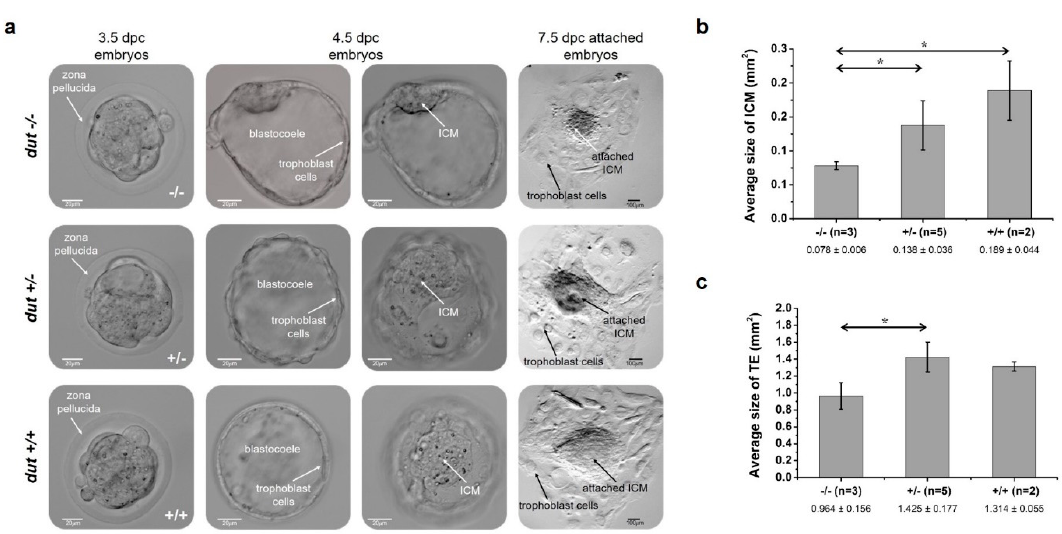
mice. ( a ) Phase contrast images of D47 homozygous ( − / − ), heterozygous (+/–), and wild-type (+/+)